Question: Looking at the figure, what chart type is it?
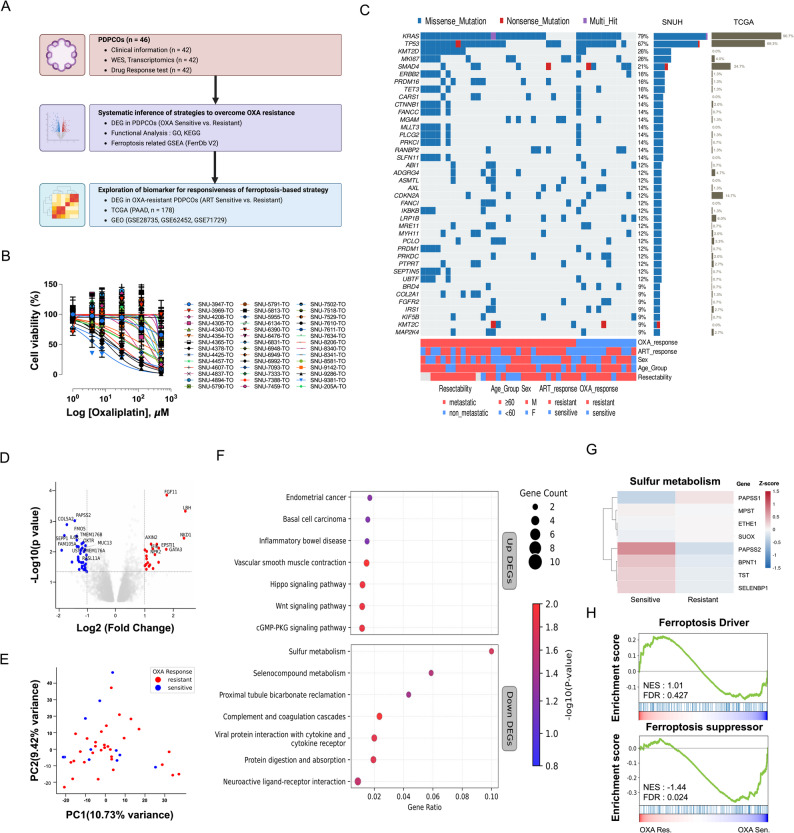
Answer: heatmap